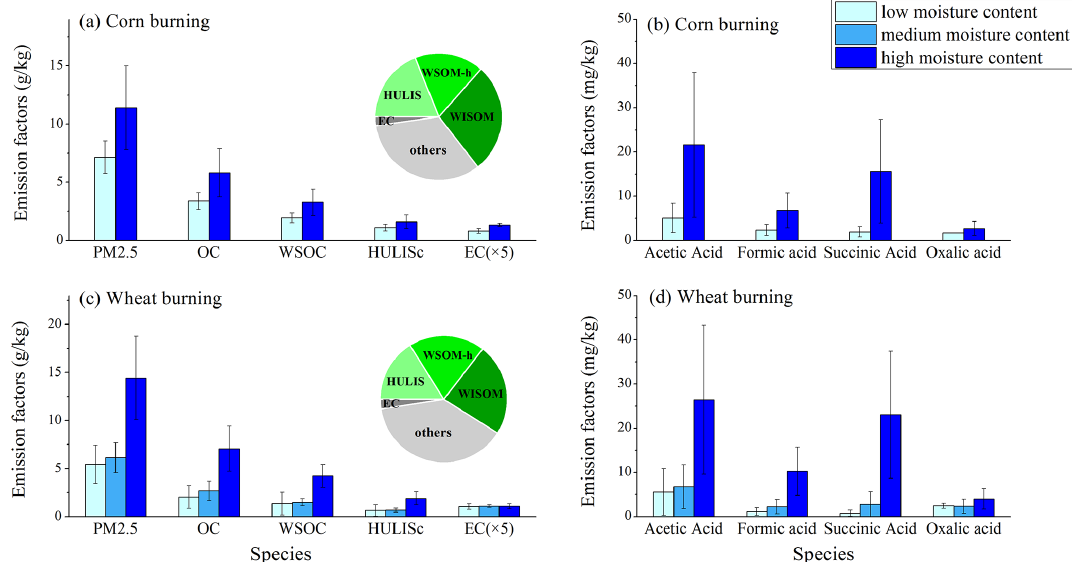
Figure 2. Emission factors of PM 2 . 5 , OC, WSOC, HULIS C and EC from (a) corn burning and (c) wheat burning and emission factors of low-molecular-weight organic acids (acetic acid, formic acid, succinic acid, and oxalic acid) from (b) corn burning and (d) wheat burning. The EC emission factors are represented by 5 × EC due to the low values. The pie charts in (a) and (c) represent the contribution of major carbonaceous aerosols to PM 2 . 5 . The high-polarity WSOM (WSOM-h) is calculated by subtracting HULIS from WSOM. Different moisture content levels correspond to those shown in Table